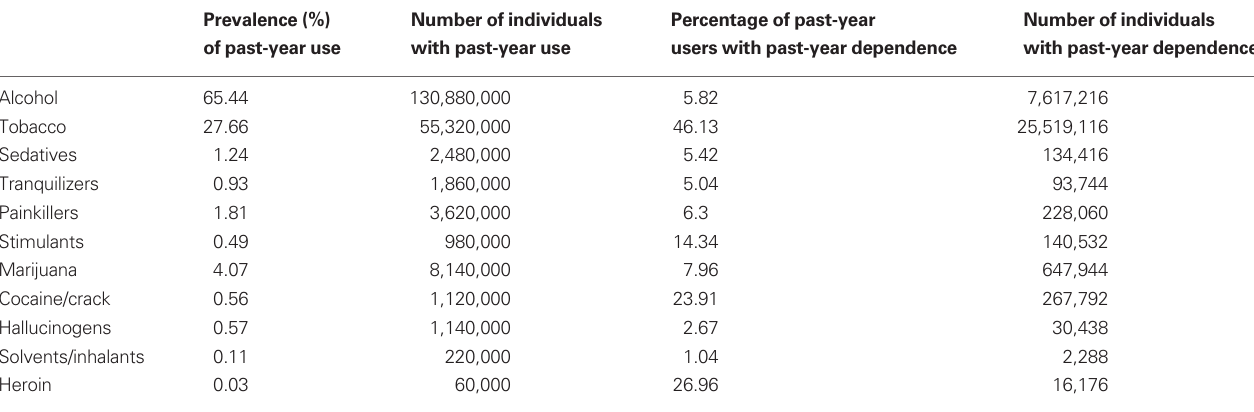
Table 1 | Past-year liability for various types of substance dependence, based on 200 million United States adults ≥ 18 years of age